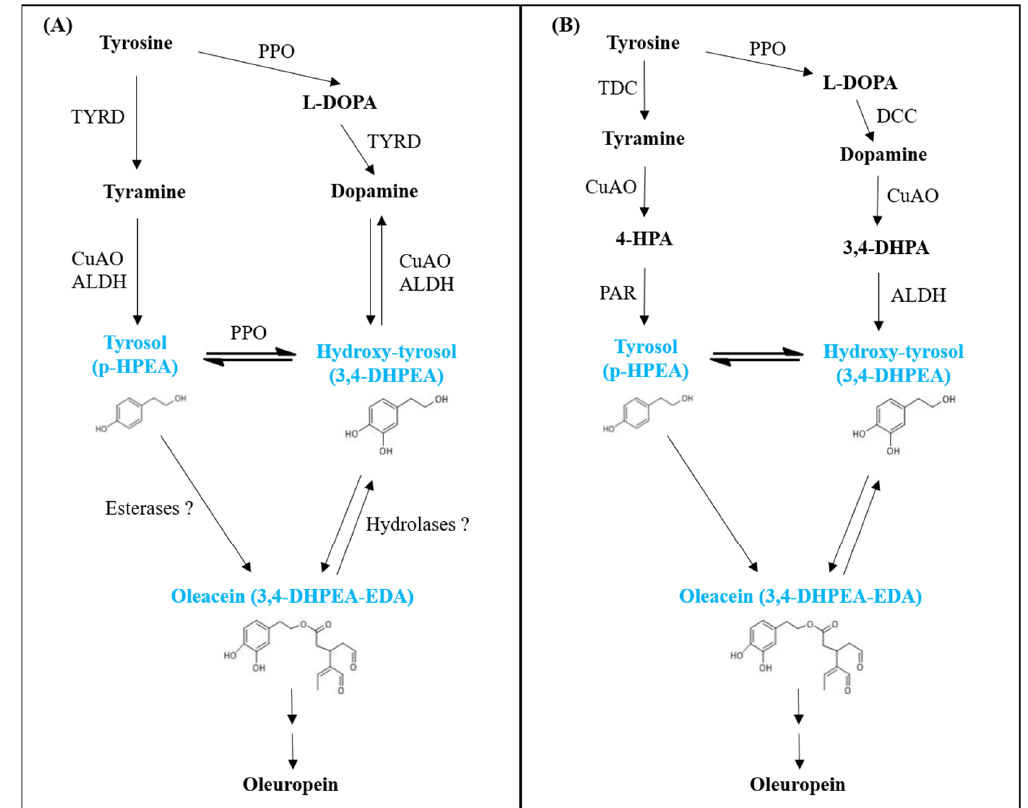
Figure 4. Simplified representation of the biosynthetic pathway of some important olive polyphenols. The previously identified enzymes and reactions ( A ) as well as the recently identified ones, with additional steps in the biosynthesis ( B ), are reported. Abbreviations: 3,4-DHPEA-EDA: elenolic acid linked to 3,4-dihydroxyphenyl ethanol (3,4-DHPEA); 4-HPA: 4-hydroxyphenylacetic acid; 3,4-DHPA: 3,4-dihydroxyphthalic acid; TYRD: tyrosine/DOPA decarboxylase; PPO: polyphenol oxidase; CuAO: copper amine oxidase; ALDH: alcohol dehydrogenase; DCC: DOPA decarboxylase; PAR: phenylacetaldehyde reductase. Adapted from [40,44].